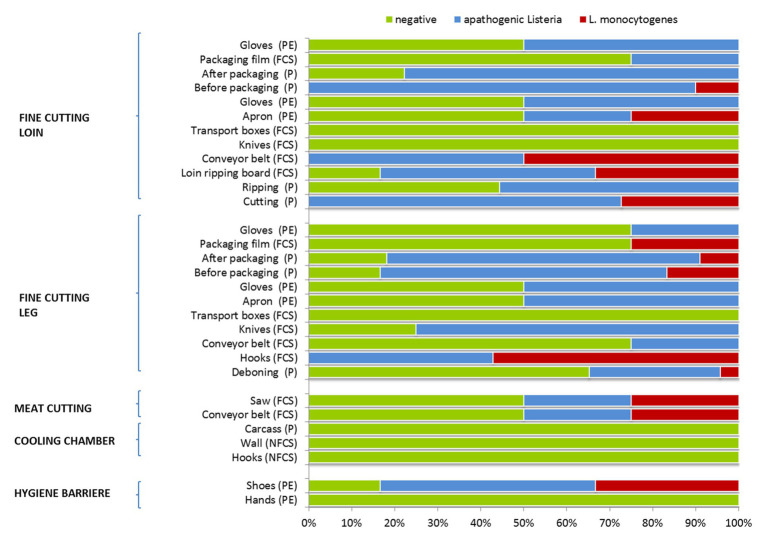
Occurrence of apathogenic listeria and Listeria monocytogenes during meat cutting. Number of samples positive or negative for Listeria spp. for each sampling position. Sample categories are abbreviated: “product” (P), “food contact surface” (FCS), “non-FCS” (NFCS), and “personnel” (PE).